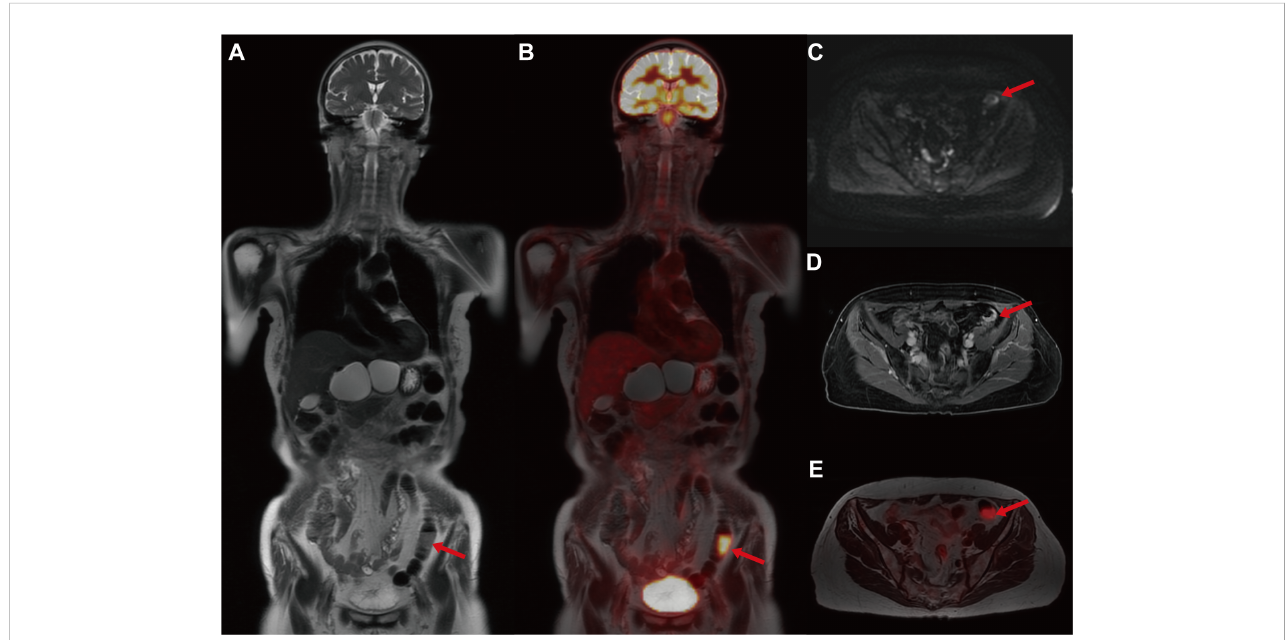
FIGURE 2 The multimodal 18F-FDG PET/MR images for evaluating the descending colon mass. (A) Coronal whole-body T2WI. (B) Coronal PET/T2WI fusion image. (C) Axial DWI. (D) Axial T1WI+C. (E) Axial PET PET/T2WI fusion image. The coronal whole-body T2WI and PET/MR fusion images showed that the abnormal hypermetabolism on PET images was a mass in the intestinal wall of the descending colon (red arrow). The thickened descending colon wall that showed markedly high signal intensity on either DWI (ADC mean = 0.75*10^-3 mm2/s) or T1WI+C and hypermetabolism on axial PET/MR fusion images was observed (red